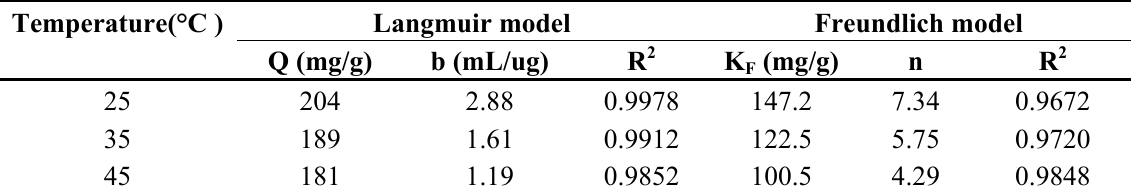
Table 4. Parameters of Langmuir and Freundlich models for Cr(VI) adsorption. Temperature(°C ) Langmuir model